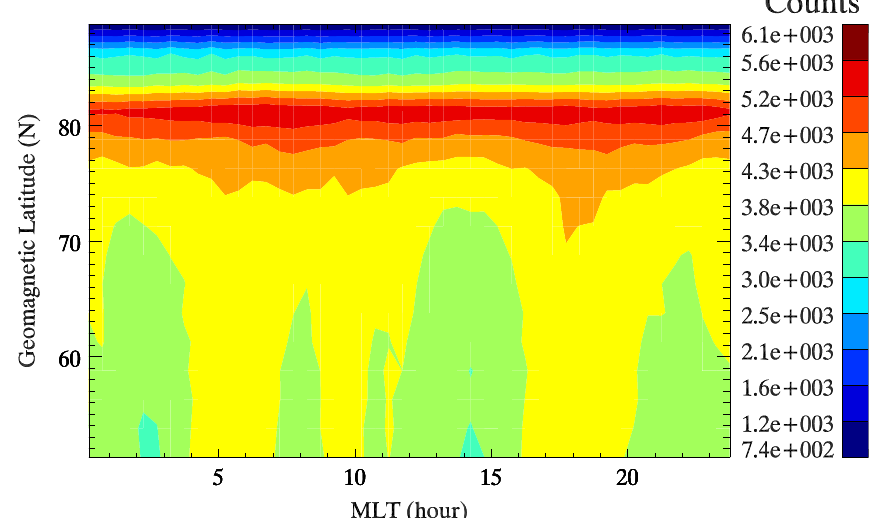
Fig. 2. Distribution of CHAMP data with respect to Geomagnetic Latitude and Magnetic Local Time (MLT). For the purpose of these statistics, bins sizes were 0.25 h in MLT and 2.5 (cid:1) in geomagnetic